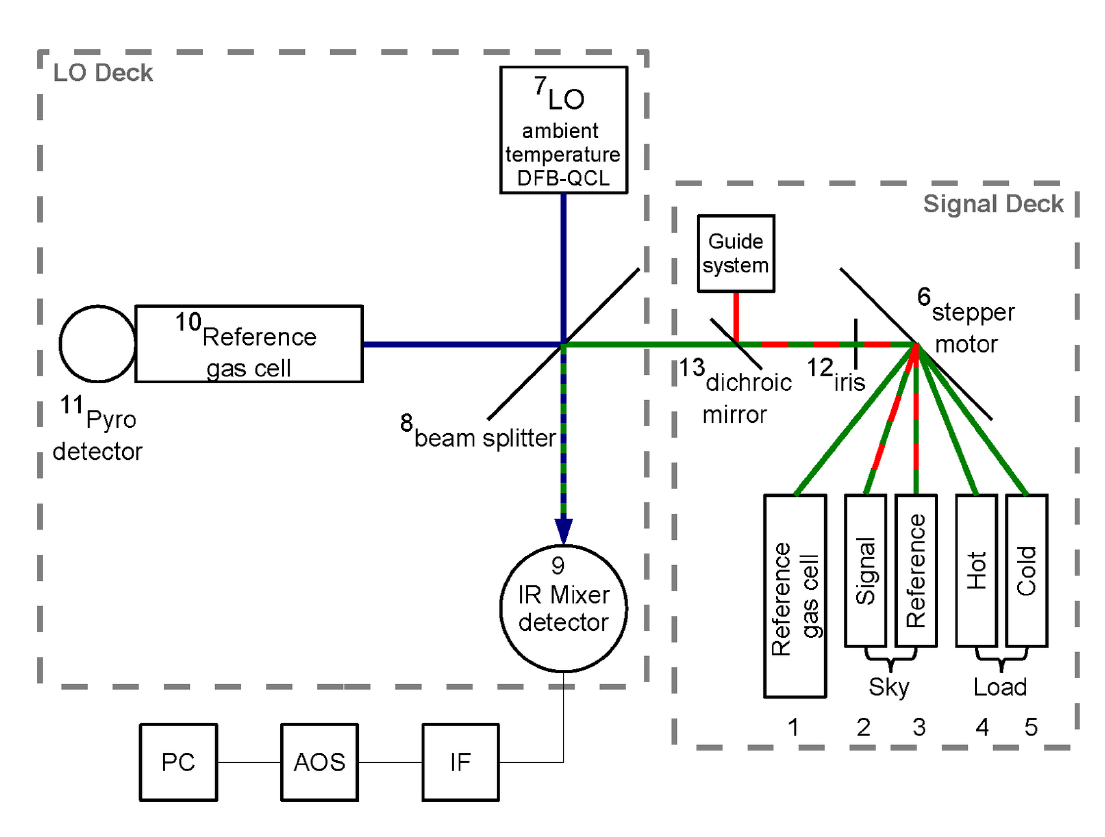
Figure 1. Schematic view of the beam path in the spectrometer. The green line indicates the IR signal beam of the different sources ( 1–5 ) selected by the scanner mirror ( 6 ). The red line indicates the optical signal used for active tracking. The blue line indicates the local oscillator (LO) ( 7 ) output beam. The two IR beams are superimposed on the beam splitter ( 8 ) and imaged on the mixer ( 9 ). The reflected fraction of the LO beam is fed through a gas cell ( 10 ) onto the pyro detector ( 11 ) used for stabilization purposes. The mixer generates an intermediate frequency, which is processed (intermediate frequency (IF)) and analyzed (acousto-optical spectrometer (AOS)) with common radio astronomical components before it is archived and displayed